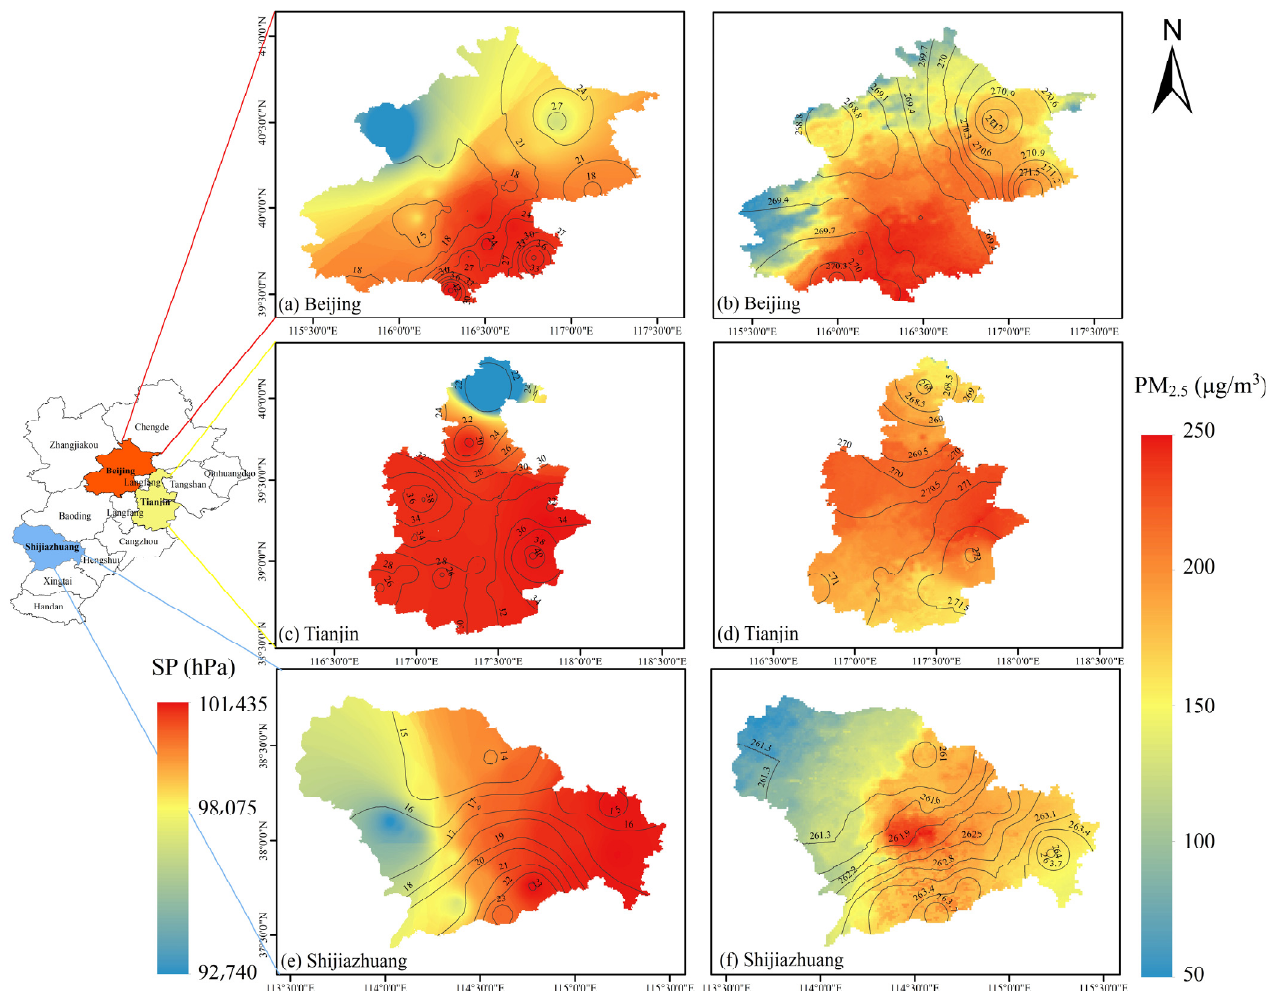
Figure 10. Pollution in Beijing (12 February 2020), Tianjin (27 January 2020), and Shijiazhuang (15 January 2020). ( a , c , e ) Depict the boundary layer height and surface pressure in the three regions. The black curve represents the boundary layer height contour (unit: m), and the background repre- sents the surface pressure. ( b , d , f ) Depict the temperature and PM 2.5 concentrations estimated by the hybrid model for the three regions, with the black curves representing the temperature contours (unit: K), and the background represents the PM 2.5 concentrations.